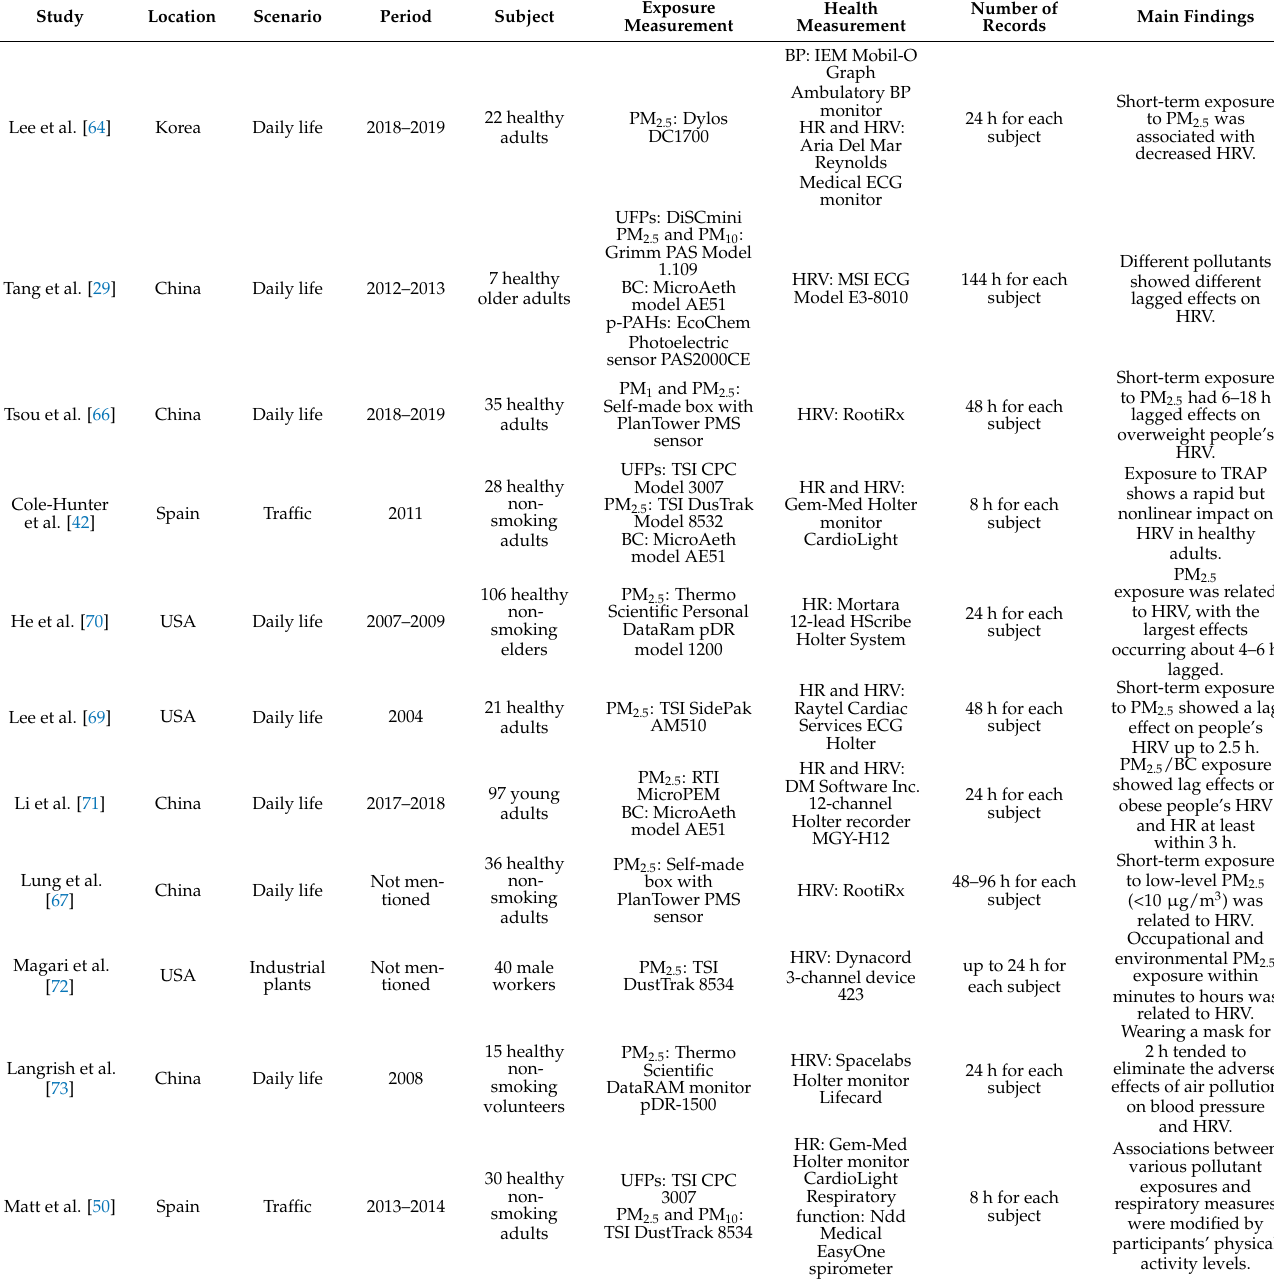
Table 3. Studies focusing on health effects of particle and heavy metal